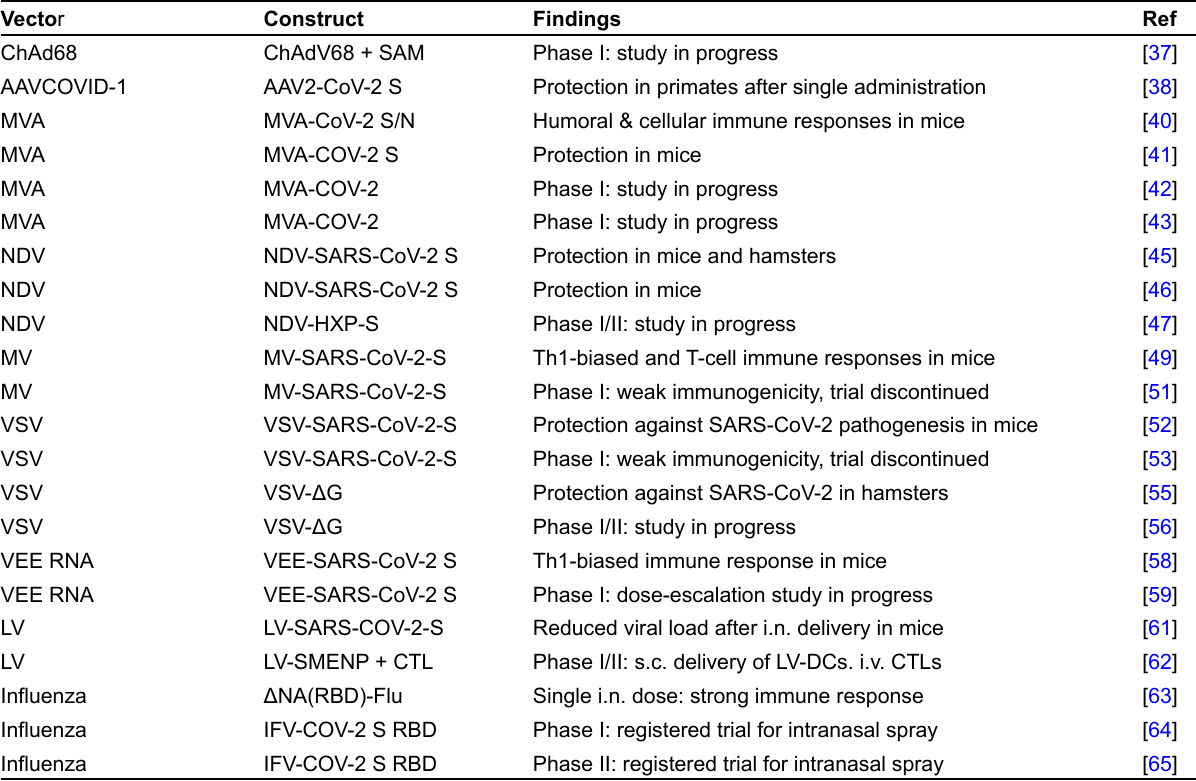
Table 1. Preclinical and clinical studies for viral vector-based COVID-19 vaccines ( continued ) Vecto r